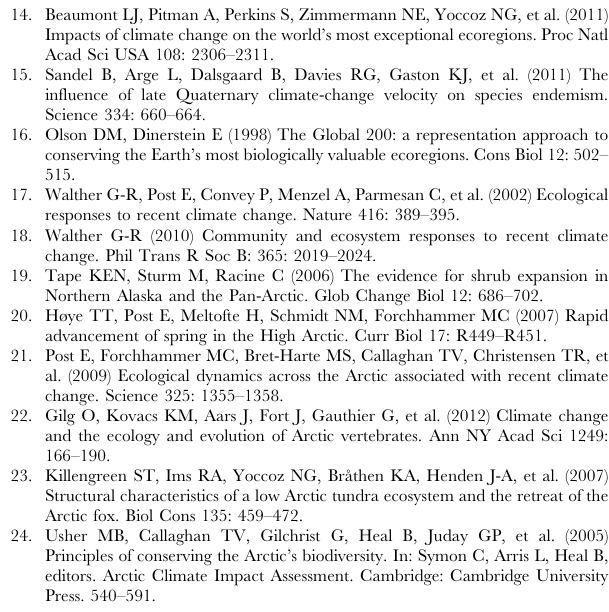
Figure S3 Coefficients of variations (CV) of RCCI across 62 GCM 6 GHG emission scenario combinations for 196 G200 ecoregions. RCCI is calculated based on differences in climate conditions between 1991 2 2010 and 2081 2 2100. Figure S4 The spatial distributions of RCCI across 196 G200 ecoregions under three different GHG emission scenarios. The calculation is based on differences in climate conditions between 1991 2 2010 and 2081 2 2100. Generated from the ensemble of 20, 23, and 19 GCMs for A ) SRES B1; B ) SRES A1B; and C ) SRES A2, respectively, the relative climate-change exposure of each G200 ecoregion is indicated by the multi-model mean RCCI (RCCI mean , illustrate as the size of the symbol) and the proportion of GCMs with RCCI $ 16 (Fr. RCCI $ 16 , illustrated as the color of the symbol). Figure S5 Definitions of wet seasons for different regions. Dry seasons are the remaining six months of a year. For each G200 ecoregion, wet and dry seasons are identified according to its geographic location. This map is drawn based on Ref. [43]. Table S1 Changes in mean climate conditions across 196 G200 ecoregions. The calculation is based on differences in climate conditions between 1991 2 2010 and 2081 2 2100, gener- ated from an ensemble of 62 GCM 6 GHG emission scenario combinations. Changes in temperature and precipitation are calculated on an annual basis ( D T, D P) as well as for wet seasons ( D T wet , D P wet ) and dry seasons ( D T dry , D P dry ). For precipitation, the proportions of GCM 6 scenario combinations with D P . 0